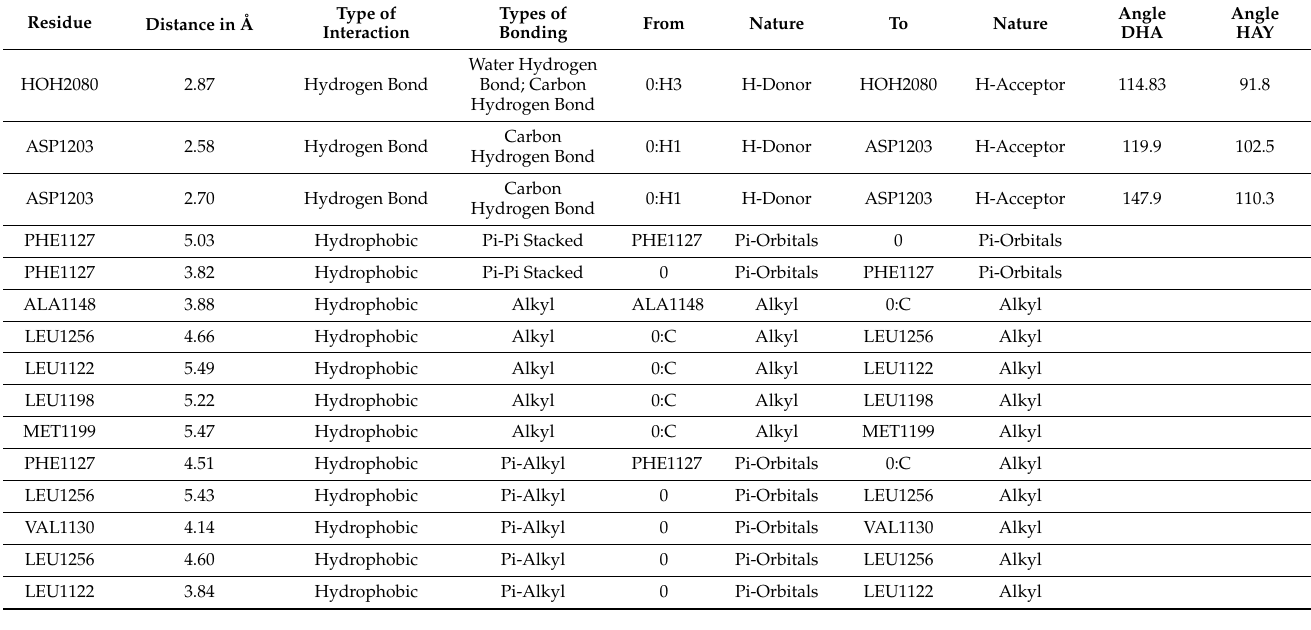
Table 3. Presentation of docking interactions of the compound 178.